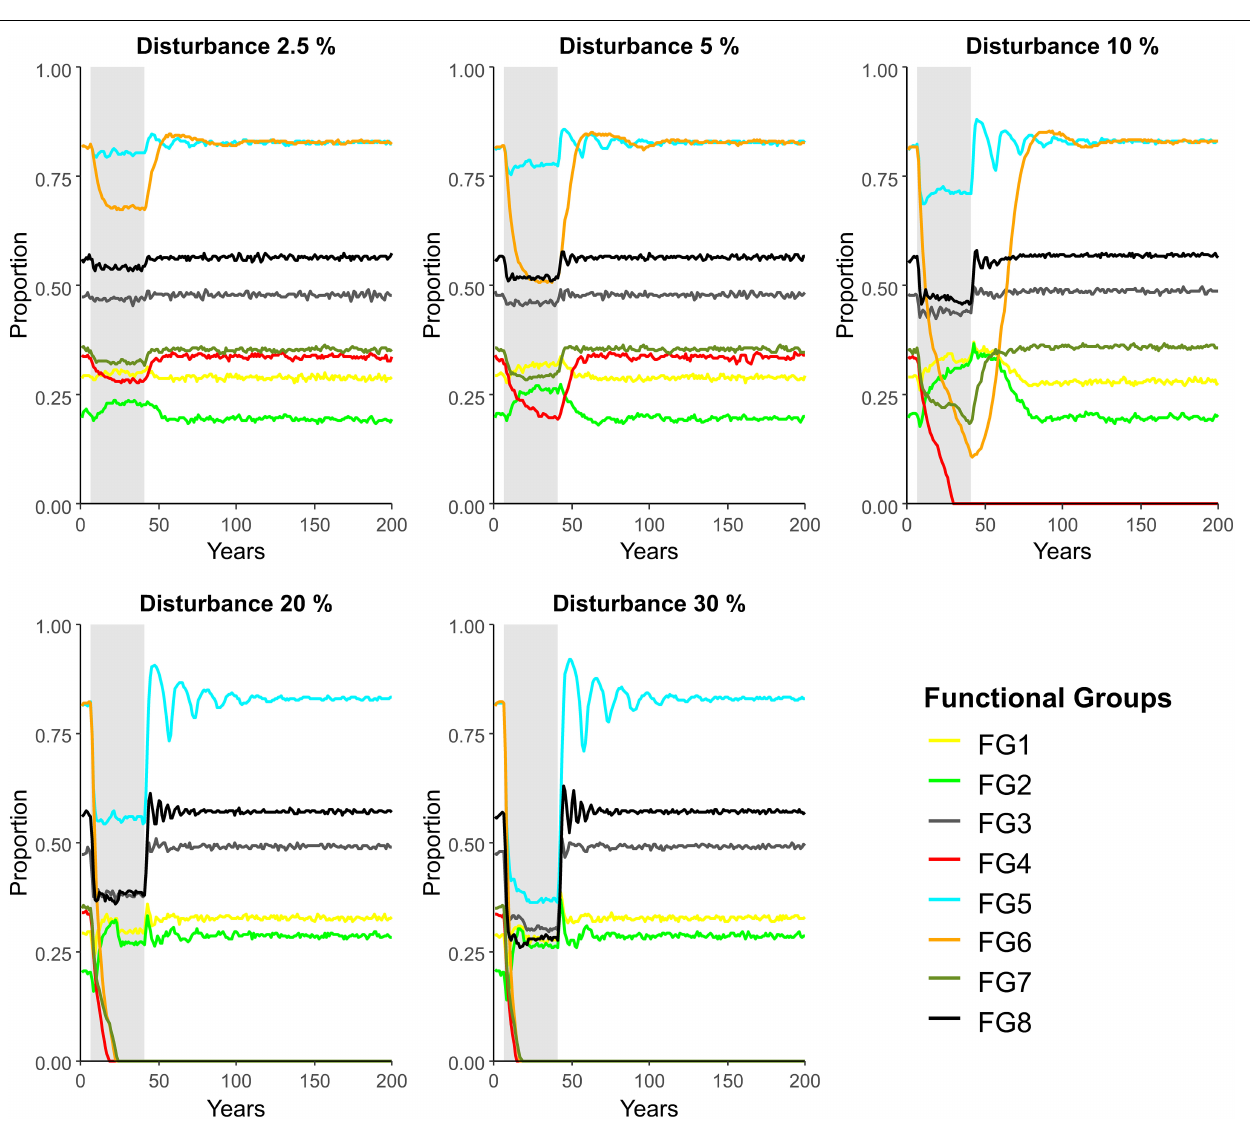
FIGURE 3 | Proportion of cells occupied by adults of eight functional groups over time in a seafloor disturbance model parametrized with no protected areas and subject to increasing disturbance per year (2.5–30%) for 35 years (gray column). FG1, Opportunistic early colonists – limited substrate disturbance; FG2, Opportunistic early colonists – considerable substrate disturbance; FG3, Substrate stabilizers; FG 4, Substrate destabilizers; FG 5, Shell hash-creating species; FG 6, Late colonizers – emergent epifauna; FG 7, Late colonizers – burrowers; FG 8, Predators and